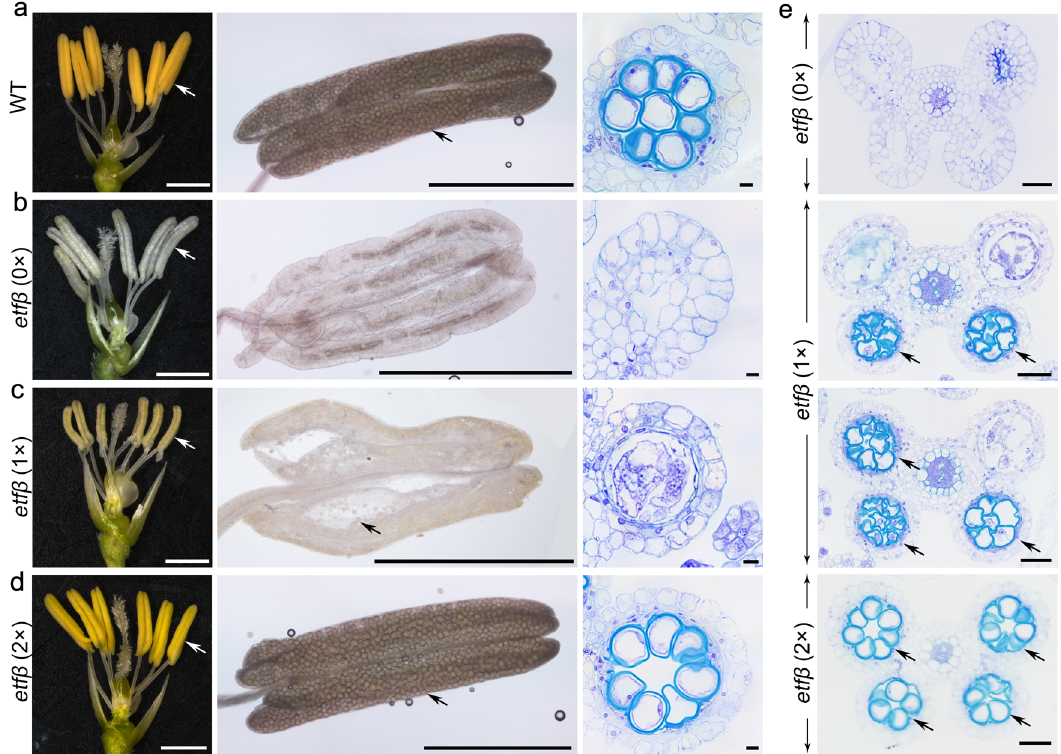
Fig. 2 Variable phenotype of etf β anthers is affected by nutritional conditions. Left: spikelet after the removal of lemma and palea. White arrows point to anthers under different nutrient concentrations. Bars = 1 mm. Middle: anther squashes stained with I 2 -KI. Black arrows point to pollen grains in anthers. Scale bars, 0.5 mm. Right: transverse sections of anthers at the same developmental stage stained with TBO. Scale bars, 5 µ m. a Morphology of WT. b Morphology of etf β treated with double distilled water [ etf β (0×)]. c Morphology of etf β treated with normal Hoagland solution [ etf β (1×)]. d Morphology of etf β treated with twice the normal concentration of Hoagland solution [ etf β (2×)]. e Phenotypes of the four locules of etf β anthers changed with nutrient concentrations (0×, 1× and 2×). Arrows point to locules within relatively normal pollen grains. Scale bars, 50 µ